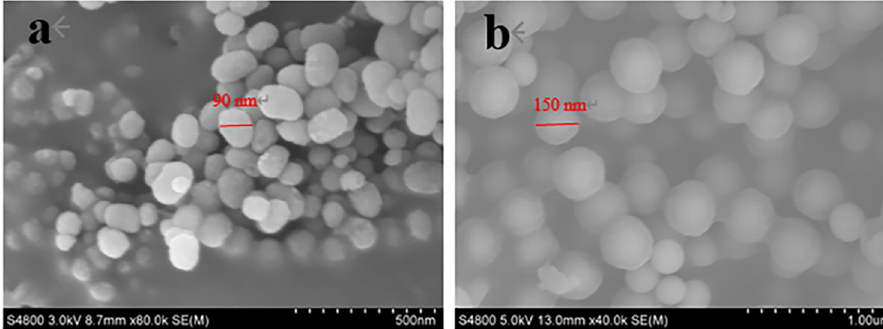
Figure 2: SEM images of ( a ) mesoporous SiO 2 and ( b )